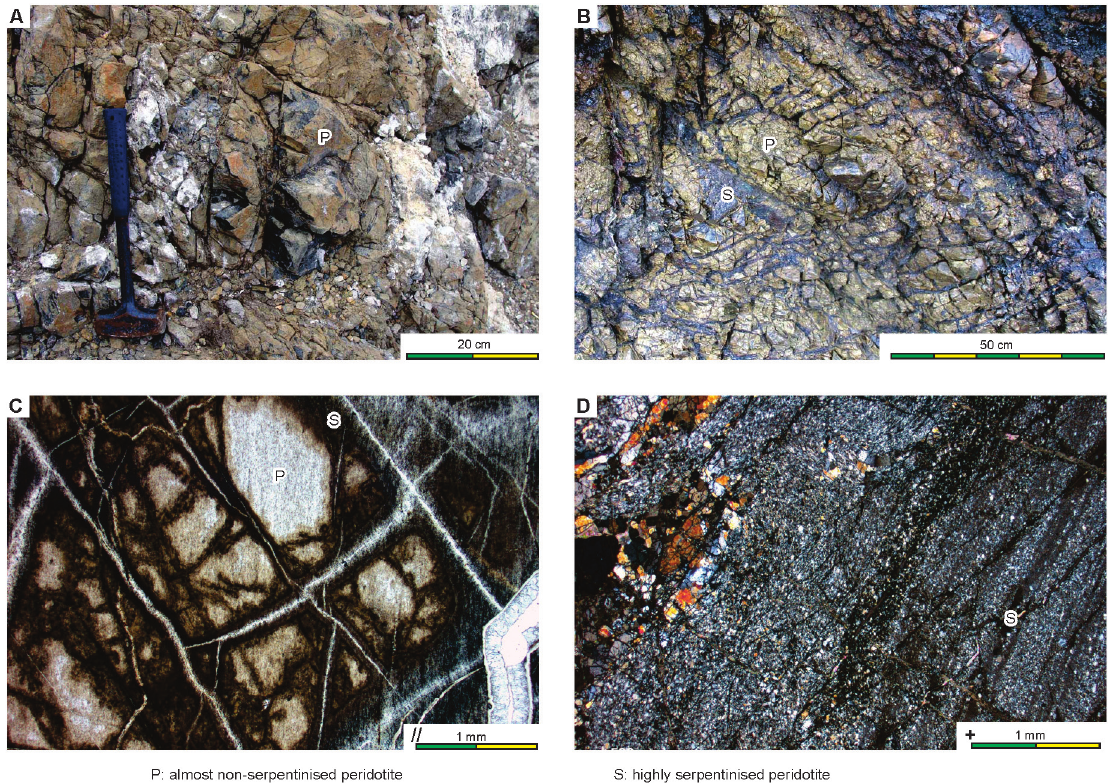
Figure 4 - Abyssal mantle ultramafic rocks of the Saint Peter and Saint Paul Rocks: A) Unserpentinised peridotite; B) Macro-scale kernel-like structure; C) Micro-scale kernel texture; D) Highly serpentinised mylonitic peridotite. The photos B, C, and D are after Sichel et al. (2011). P - unserpentinised peridotite; S - serpentinised